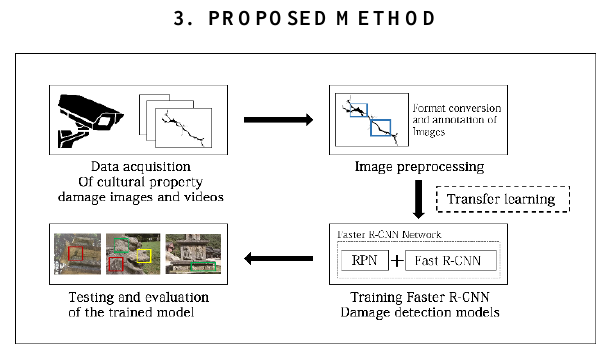
Figure 1. The workflow of the proposed method.